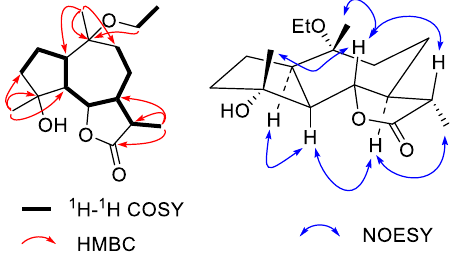
Figure 3. Key 1 H- 1 H COSY, HMBC, and NOESY correlations of 2 . Compound 3 was obtained as a colorless crystal plate The molecular formula of